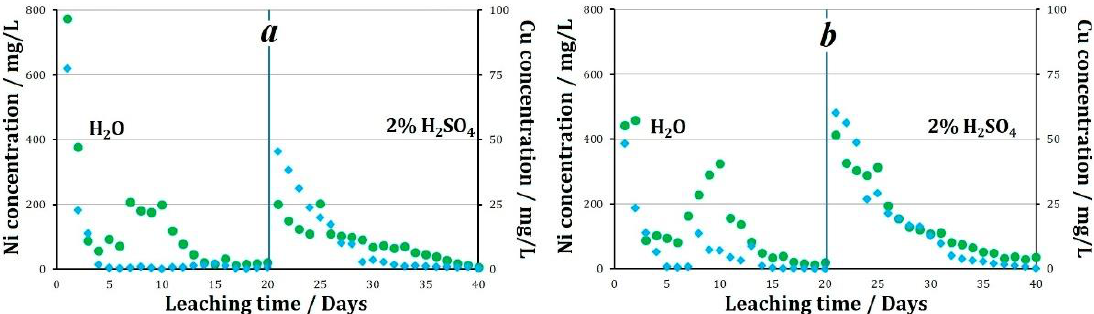
Figure 7. The concentration of metals in pregnant liquors during leaching of granules prepared using various oxidizing agents followed by storage at below 0 °С ambient temperatures, ( a ) — 2% H 2 SO 4 + Fe 3+ , ( b ) — 2% H 2 SO 4 + NO 2 − .